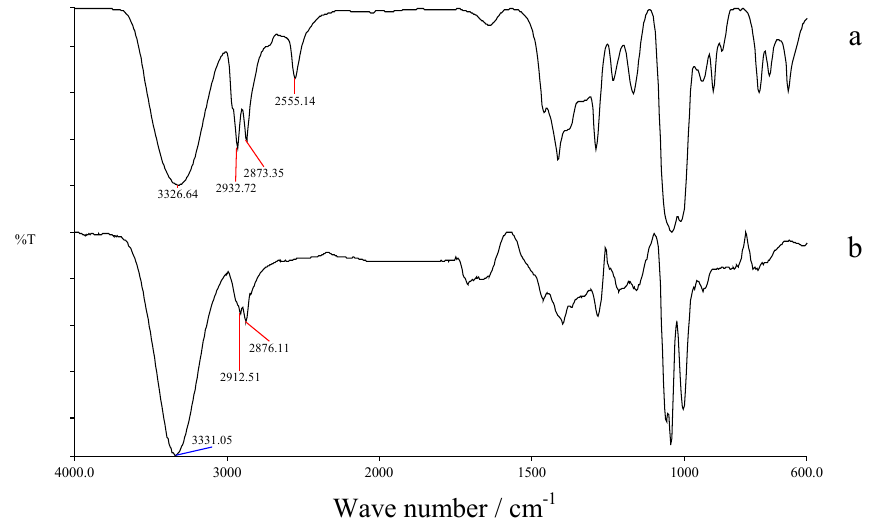
Figure 1. ATR-FTIR spectra of 2-mercaptoethanol (a) and ME/Au SAMs